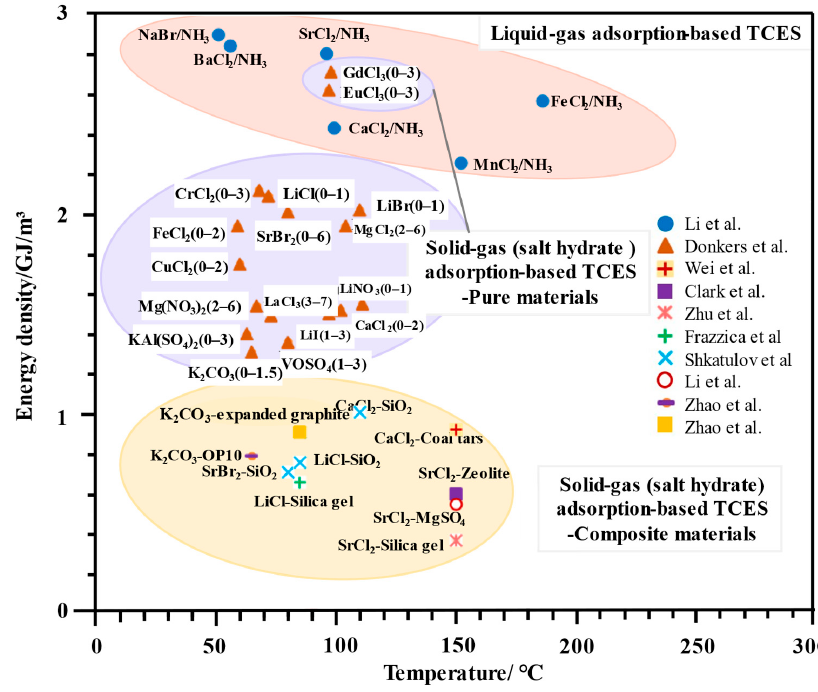
Figure 5. Energy density of adsorption-based TCES materials [17–26].